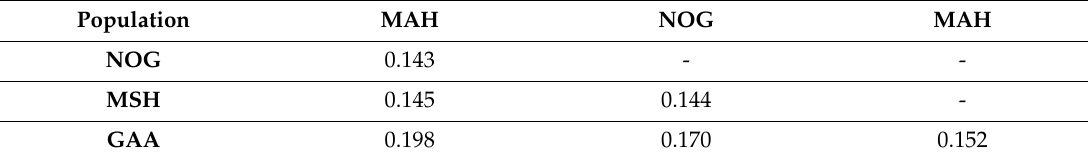
Table 8. Pairwise Population Matrix of Nei Genetic Distance among native populations. Population